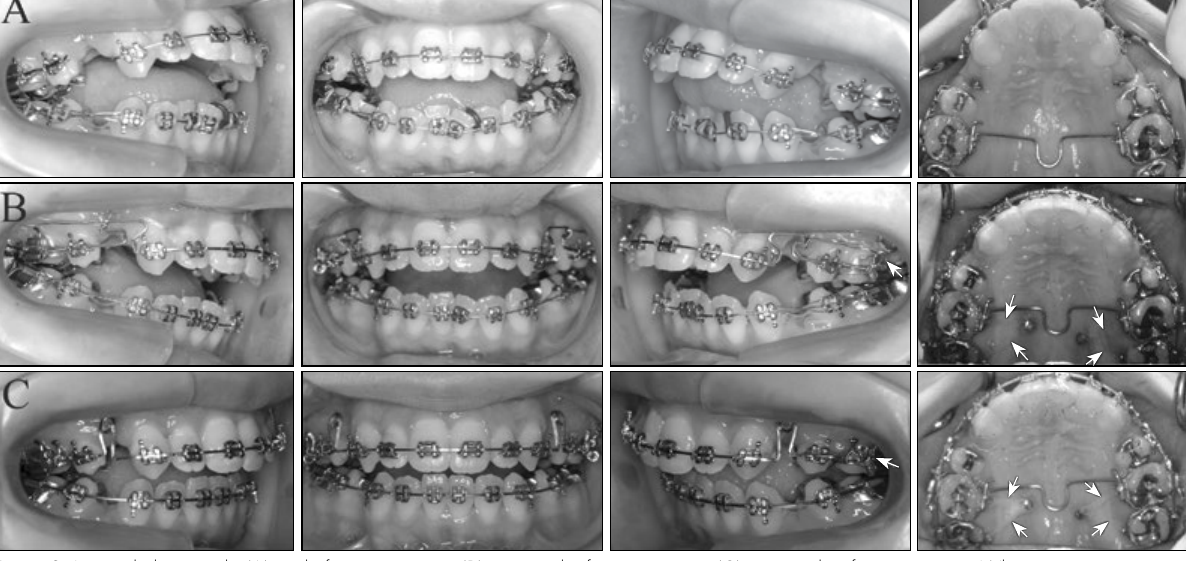
Figure 3. Intraoral photographs (A) just before corticotomy; (B) one month after corticotomy; (C) two months after corticotomy. White arrows shows the placement of